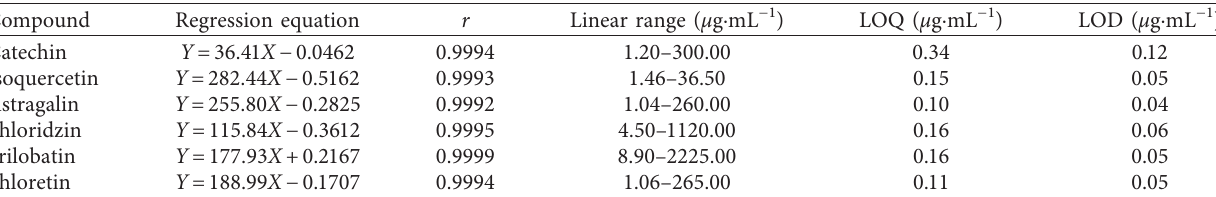
Table 4: Linear relationship, LOQ, and